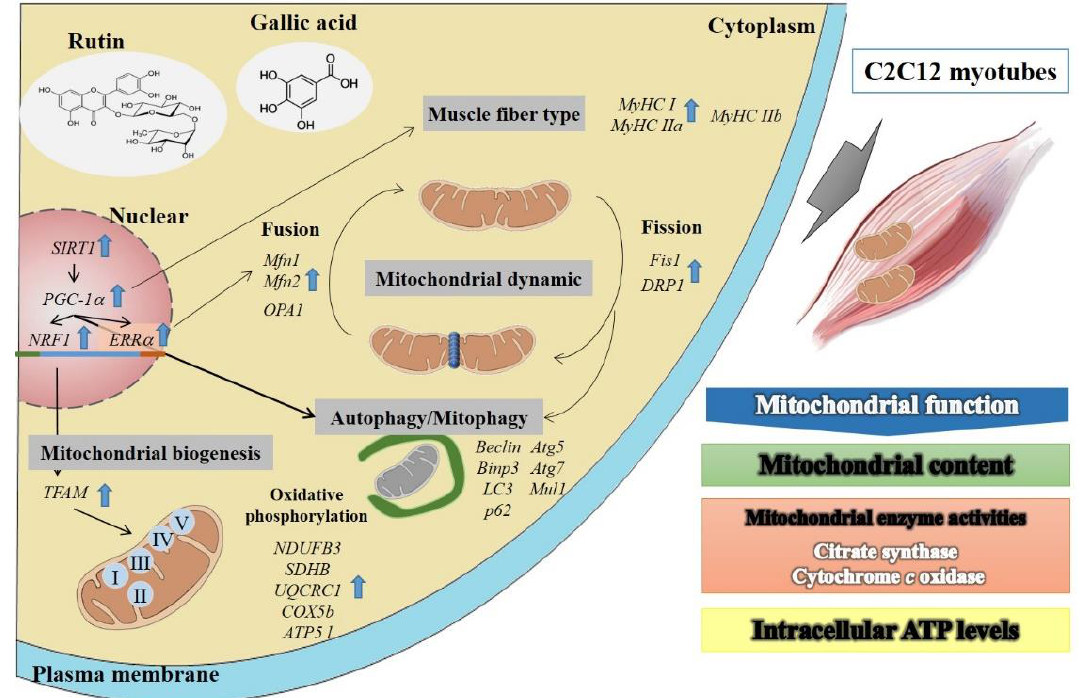
Figure 6. Schematic representation of action mechanism by gallic acid and rutin on mitochondrial functions in C2C12 myotubes. Improvement of functions of the mitochondrial network will result in increased exercise performance. The mitochondria in skeletal muscle are dynamically balanced. By enhancing the performance of genes, such as mitochondrial synthesis, fusion/fission, and mitochondrial autophagy, it can enhance mitochondrial function and improve metabolic dysfunction diseases. Gallic acid and rutin are the most potent activators of mitochondrial function, which is mediated through SIRT1 pathway. The results show that it has the best performance in enhancing the mitochondrial function of C2C12 myotube cells (mitochondrial DNA content, mitochondrial number, enzyme activities, and ATP content). It can further promote the downstream molecular mechanisms of mitochondrial biosynthesis genes ( PGC-1 α , NRF1 , ERR α , and TFAM ), mitochondrial oxidative phosphorylation ( NDUFB3 , SDHB , UQCRC1 , COX5b, and ATP5 l ), oxidized muscle fibers ( MyHC I and MyHC IIa ), fusion/fission ( Mfn1 , Mfn2 , OPA1 , DRP1 , and Fis1 ), and mitochondrial autophagy ( Atg5 , Atg7 , Beclin , Bnip3 , LC3II , Mul1 , and p62 ) gene expressions to improve skeletal muscle endurance. Therefore, gallic acid and rutin may be beneficial against exercise performance and anti-fatigue